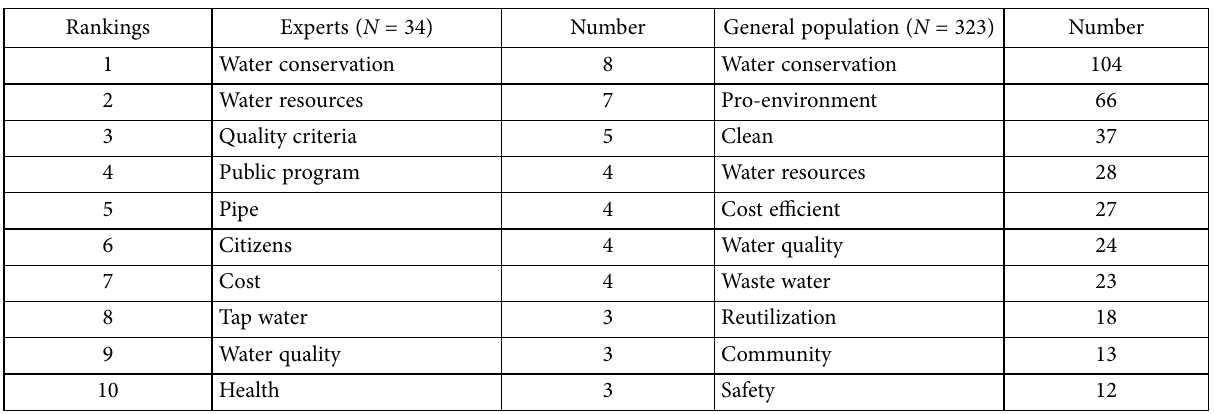
Table 2. The highest-frequency codes for two samples for the use of toilet